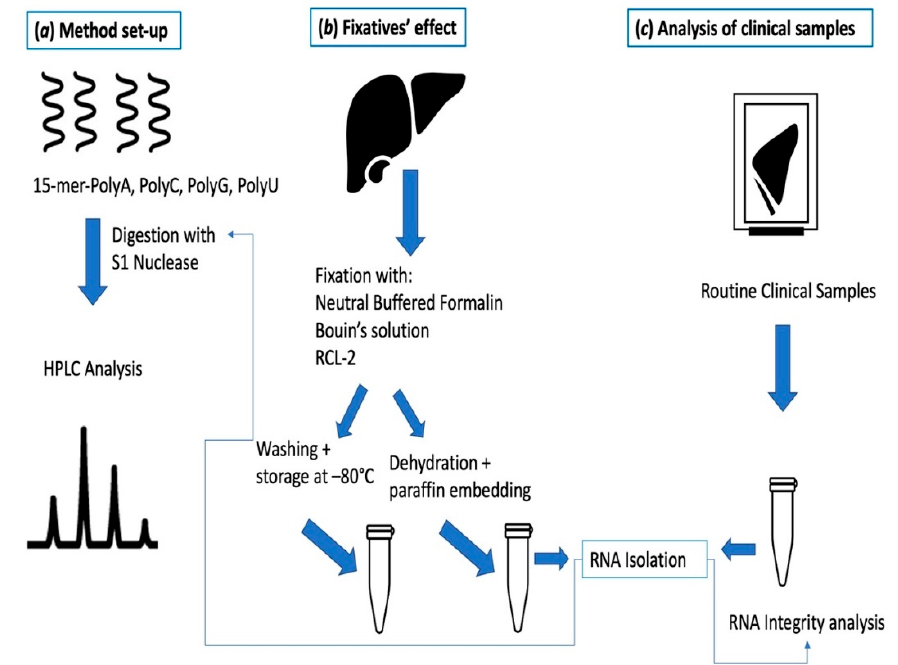
Figure 1. Design of the study: ( a ) Method set-up for the optimization of the digestion conditions and HPLC separation using 15-mer-mono-oligonuclotides; ( b ) Study on fixatives’ effect based on the treatment of the same tissues (mouse livers) with 3 different fixatives and application of the HPLC method to RNA extracts; ( c ) Application of the HPLC method to RNA obtained from routine clinical samples. In sections ( b ) and ( c ), after isolation, RNA is parallelly submitted to digestion followed by HPLC analysis and to integrity analysis.